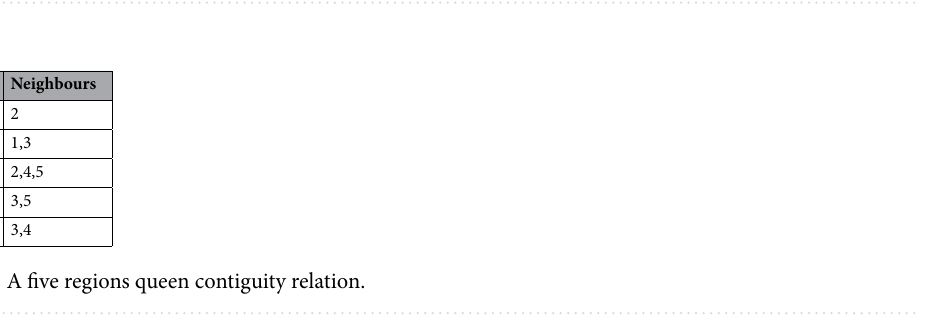
Figure 1. An illustration of the contiguity-based neighbourhood.